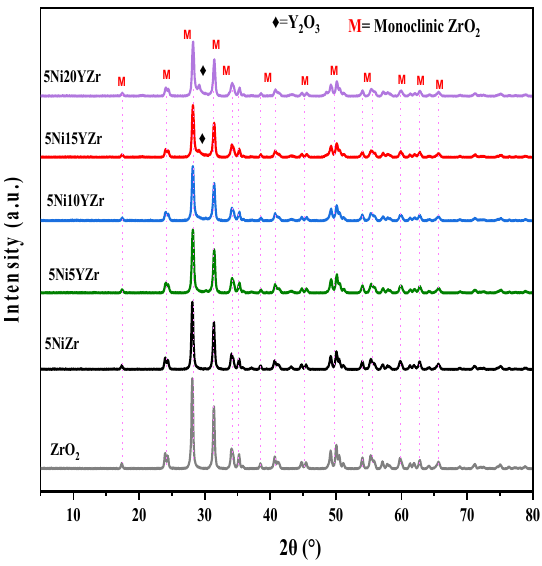
Figure 4. The XRPD patterns of synthesized catalysts.